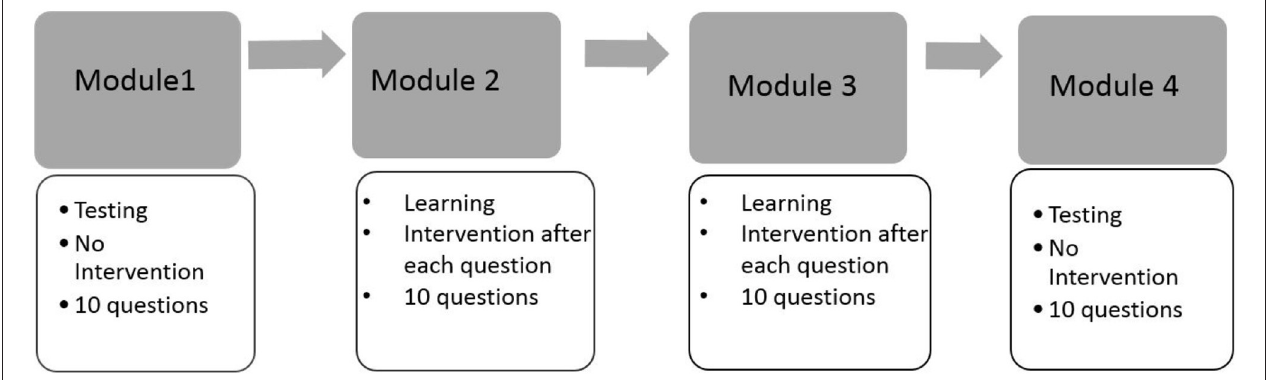
FIGURE 1 | The design of the spatial rotation learning